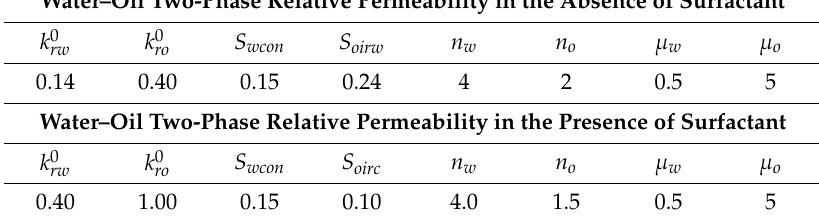
Table 3. Corey model parameters for water–oil two-phase relative permeability in the presence and absence of